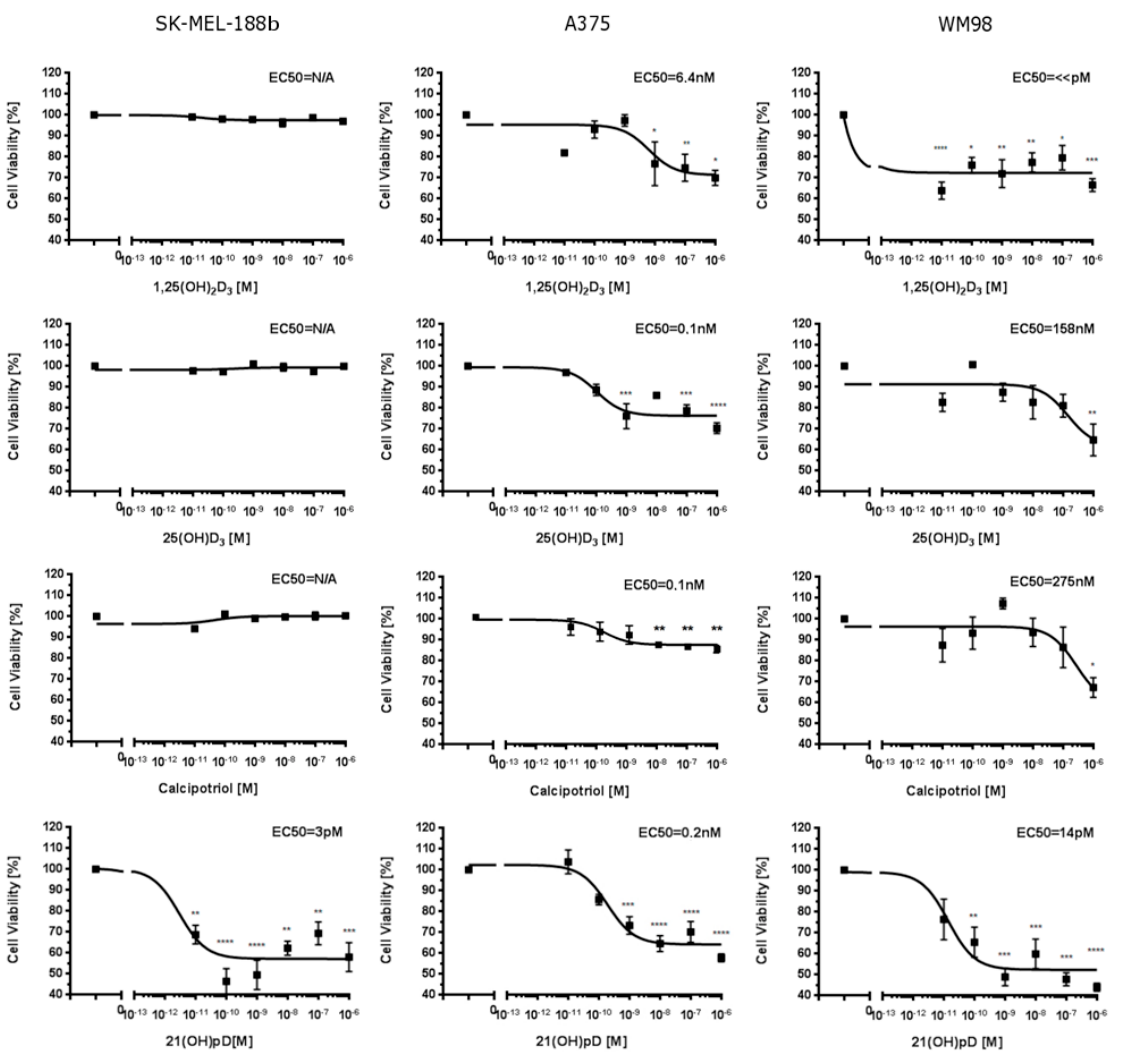
Figure 2. Effects of 1,25(OH) 2 D 3 , 25(OH)D 3 , calcipotriol and 21(OH)pD on growth of human SK-MEL-188b, A375 and WM98 melanoma cells. Cells were seeded into 96-well plates and incubated in a medium supplemented with serial dilution of vitamin D analogs from 0.01 nM to 1000 nM concentration (as described in Material and Methods). The statistical significance of results has been analyzed using one-way ANOVA (GraphPad Software, San Diego, CA, USA) and data are presented as means ± SEM for at least three independent measurements. The cutoff point of significance was defined as p < 0.05 (* p < 0.05, ** p < 0.01, *** p < 0.001, **** p < 0.0001).